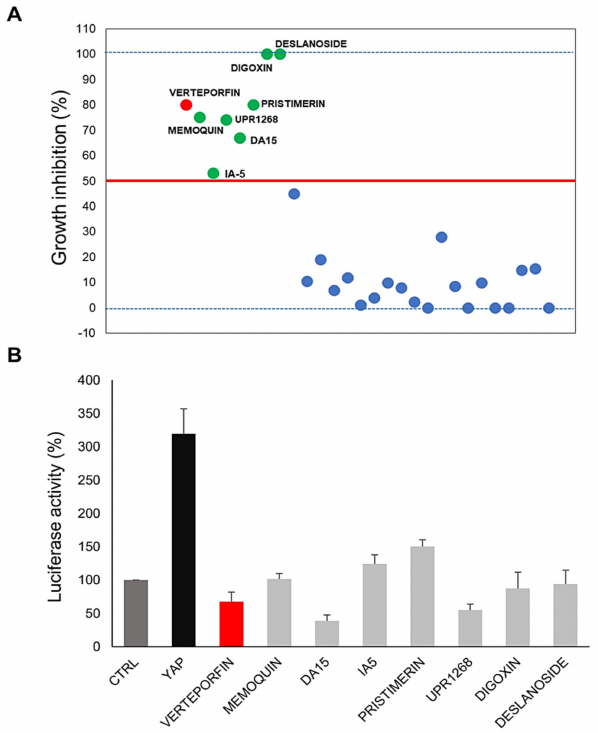
Figure 6. HaCaT cell growth inhibition and luciferase assay. ( A ) Plots showing growth inhibition of HaCaT cells treated with a library of compounds at 10 µ M. Verteporfin (reference compound) is highlighted in red and the active compounds in gray. Blue dots represent compounds with no effect on the proliferation. ( B ) Detection of YAP-TEAD activity by luciferase assay after 18 h of treatment. Verteporfin was used as reference drug (red bar). YAP1/3 indicates the ratio between the YAP plasmid (activator) and pGL4/hRluc plasmid (experimental vector). Error bars represent s.d. (n =